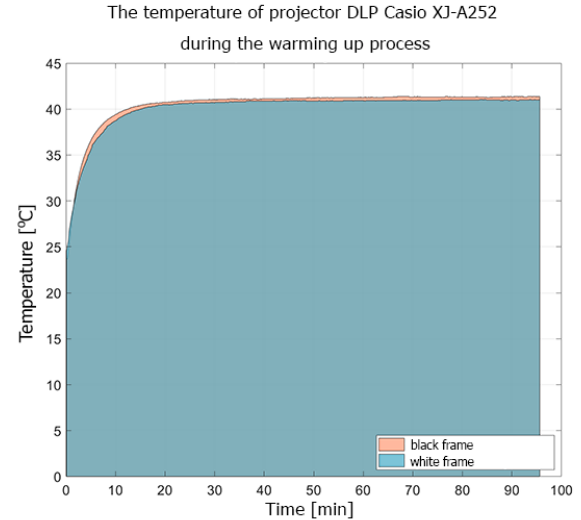
Figure 6. The temperature registered during the warming-up experiment of the DLP Casio XJ-A252 projector displaying white and black frames. The temperature was measured by the PT100 sensor attached to the optical system housing.